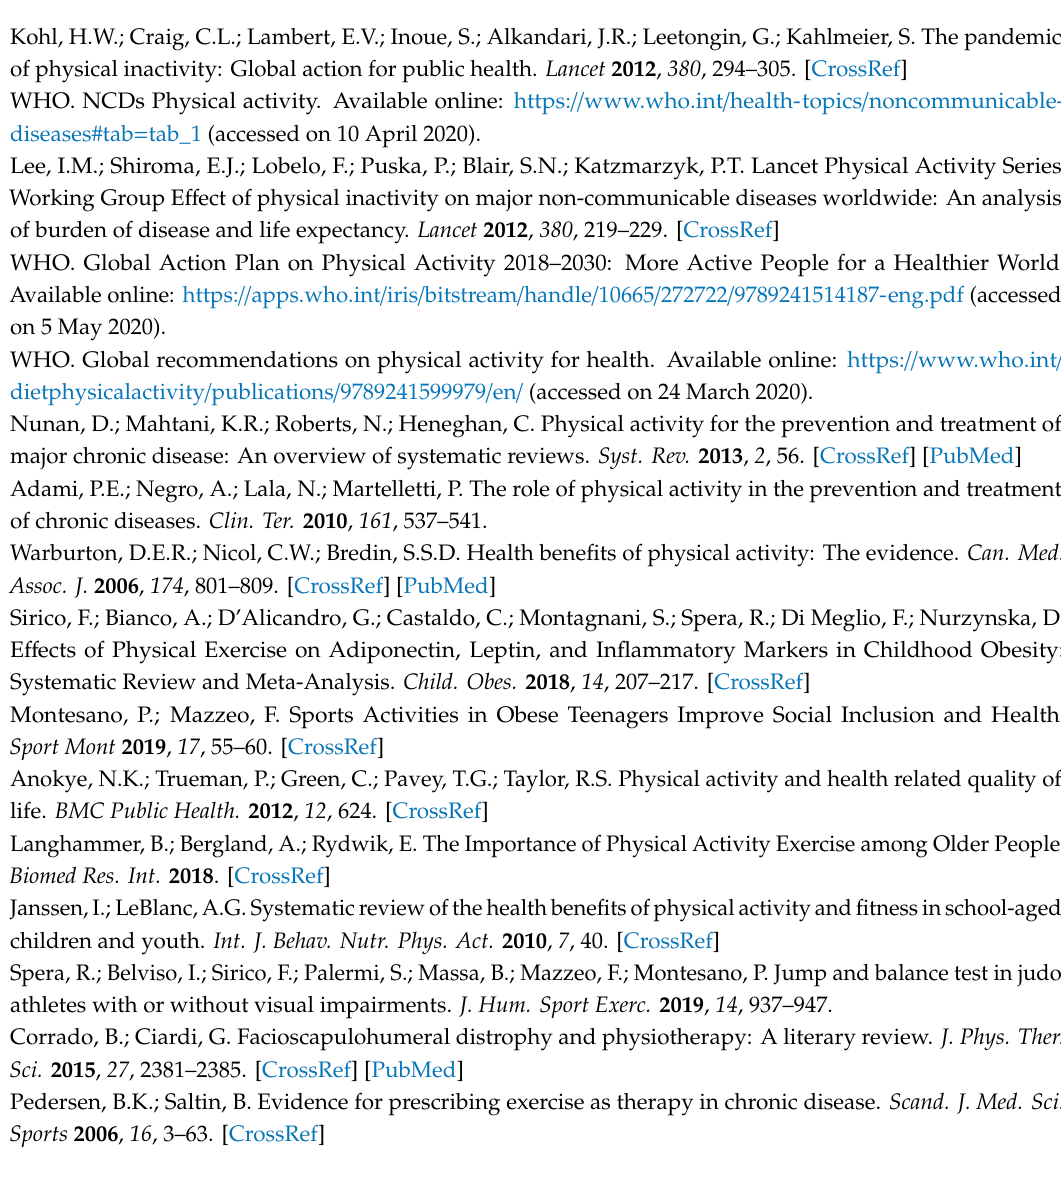
Table S1: Survey (Italian version), Table S2: Survey (English